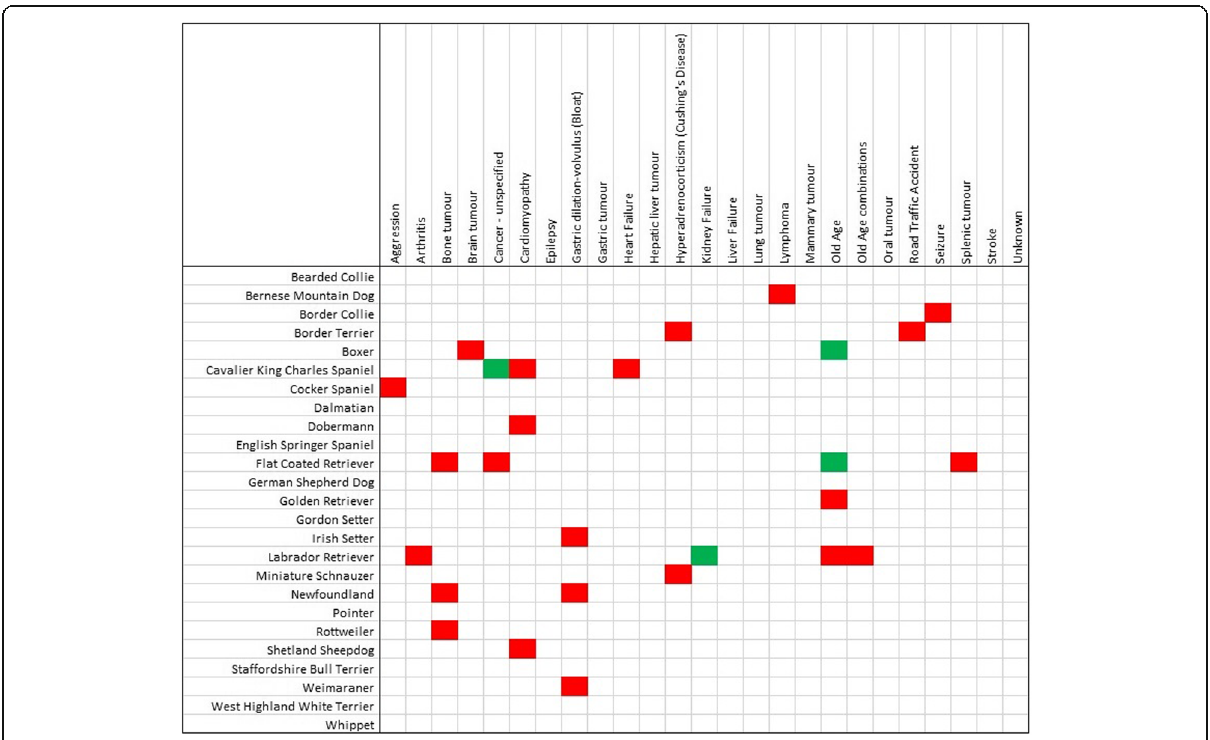
Fig. 3 Significant differences in proportional mortality within breed compared to overall. Significantly higher (red), and lower (green) within breed proportional mortality (WBPM) than overall proportional mortality (OPM) ( P < 0.05) for the 25 most commonly reported causes of death among the twenty-five breeds with > 50 deaths reported with ≥ 50 reports ( n = 3744